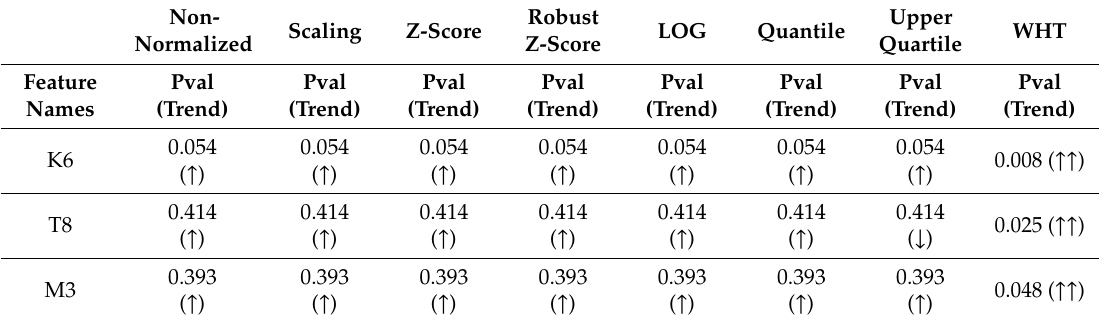
Table 5. Results from the Wilcoxon signed-rank test indicating association between MRI phenotype and molecular classification HER2 + versus